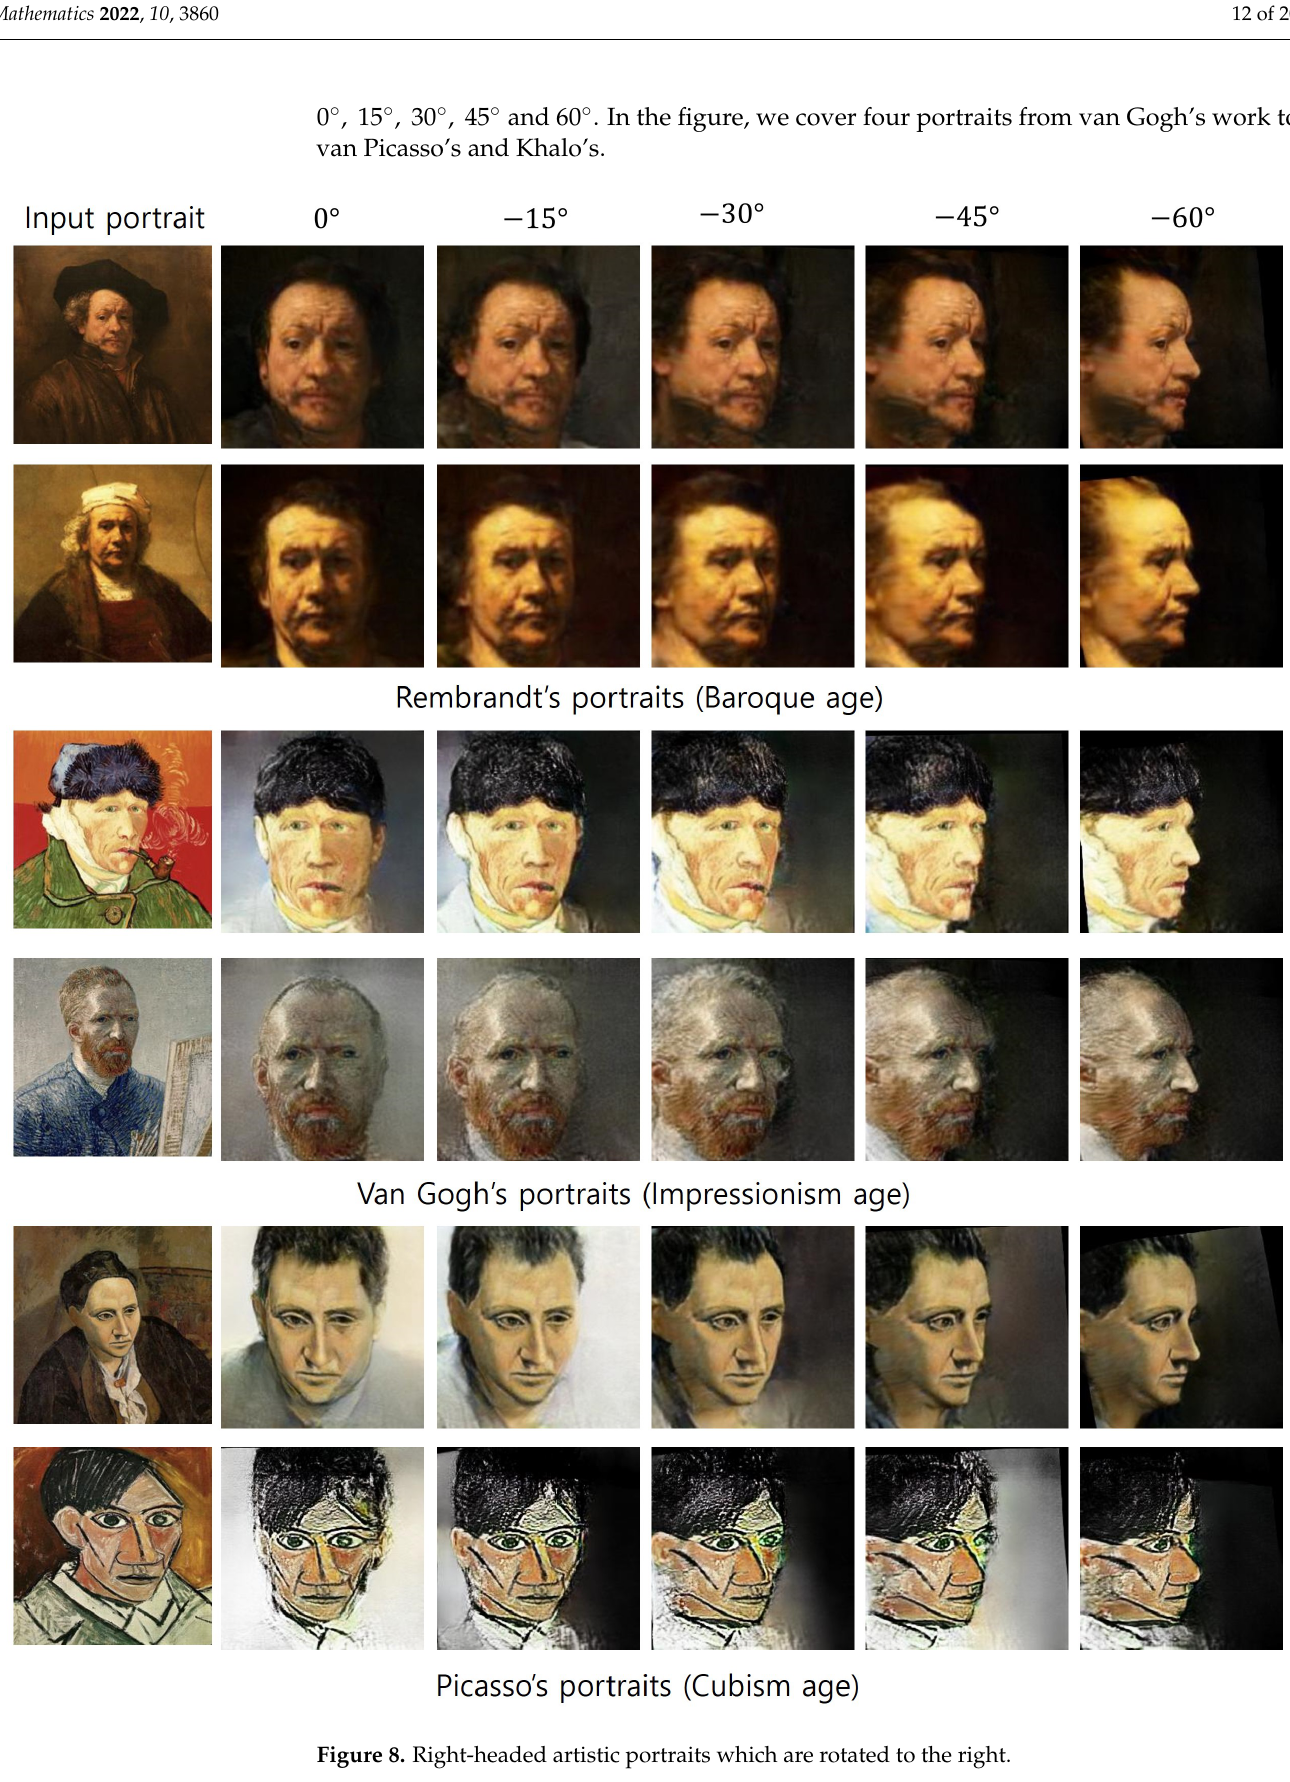
Figure 8. Right-headed artistic portraits which are rotated to the